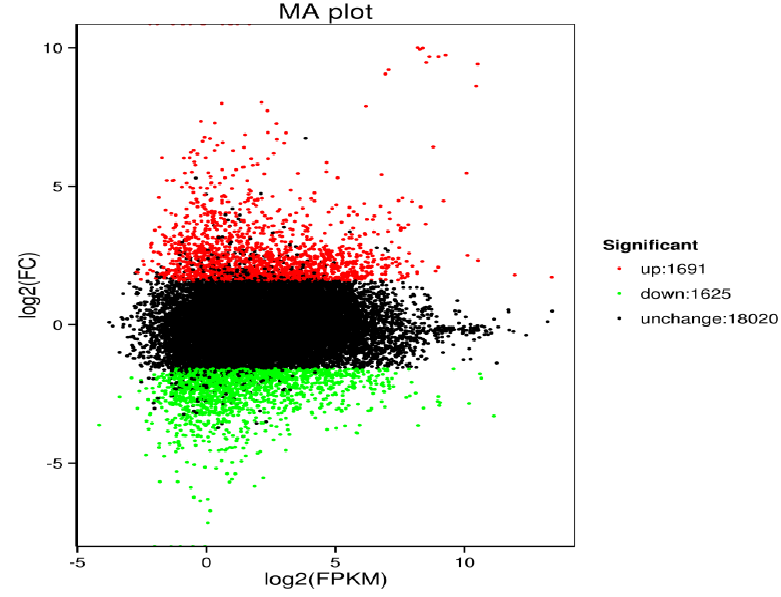
Figure 4. MA map of differentially expressed genes. Each point represents a gene in the MA map of differentially expressed genes. The abscissa is the A value: log2 (FPKM), the logarithm of the mean value of the expression in the two samples. The ordinate is the M value: log2 (FC), the logarithm of the difference in gene expression between the two samples, which was used to measure the difference in the level of expression. The green and red dots represent genes with significant differences in expression levels, green represents downregulated gene expression, red represents upregulated gene expression, and black spots represent genes with no significant differences in expression.